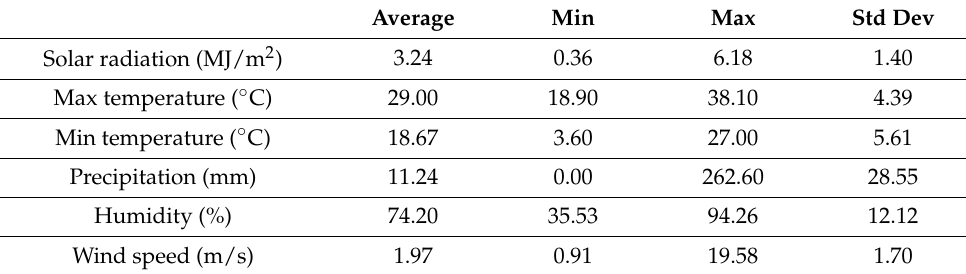
Table 4. Daily information on the environmental